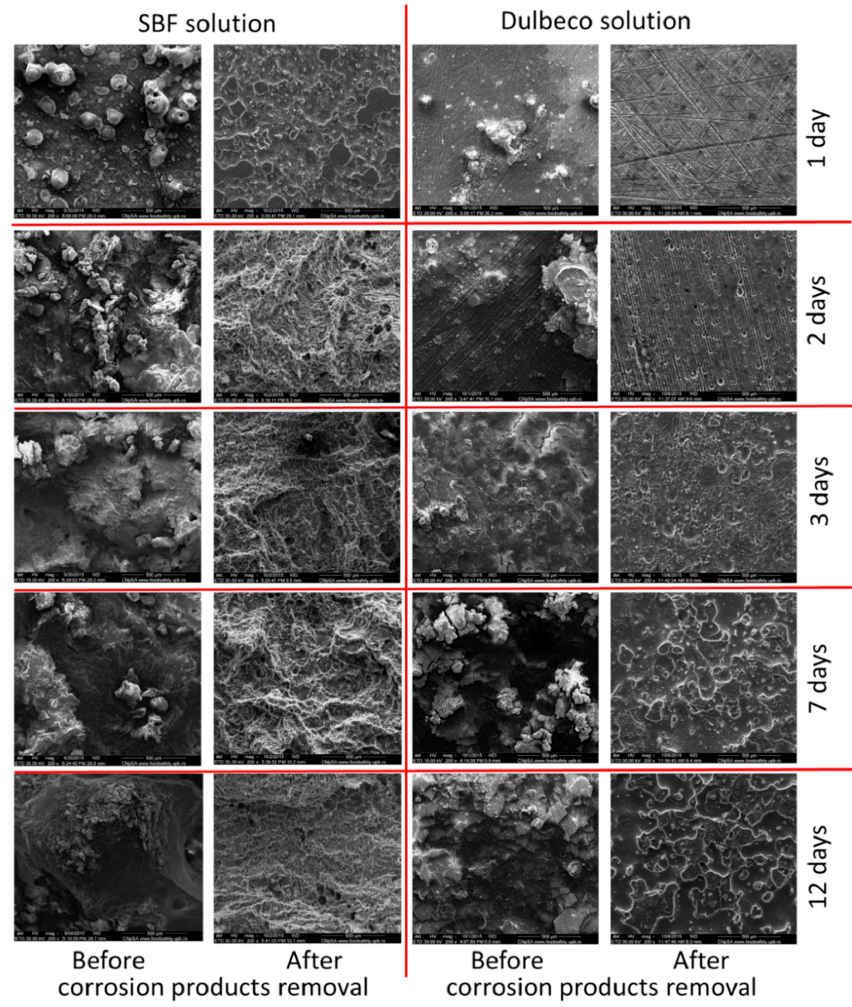
Figure 12. SEM images on the samples surfaces at 1, 2, 3, 7, and 12 days after immersion in SBF and Dulbecco medium before and after the corrosion products removal. After removing the corrosion products from the surface of the experimental alloy Mg-1Ca, surface morphologies specific to crevasse corrosion and pitting type were high- lighted.